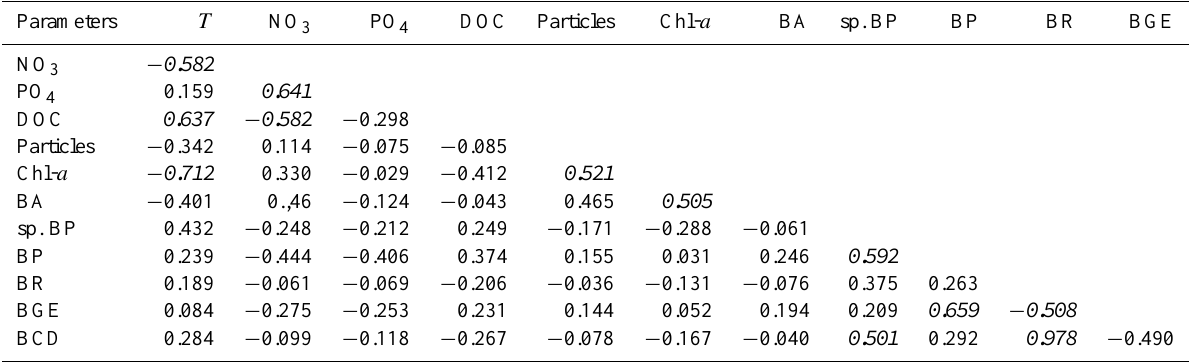
Table 1. Spearman correlation matrix of all parameters for which significant ( P < 0 . 0001) and relevant ( ρ> 0 . 5) correlation coefficients were found (in italics). The threshold for P < 0 . 05 was at ρ =0.2. GPP, NCP and R data were not included in this analysis, since they were sampled at a lower frequency. sp. BP, cell-specific bacterial